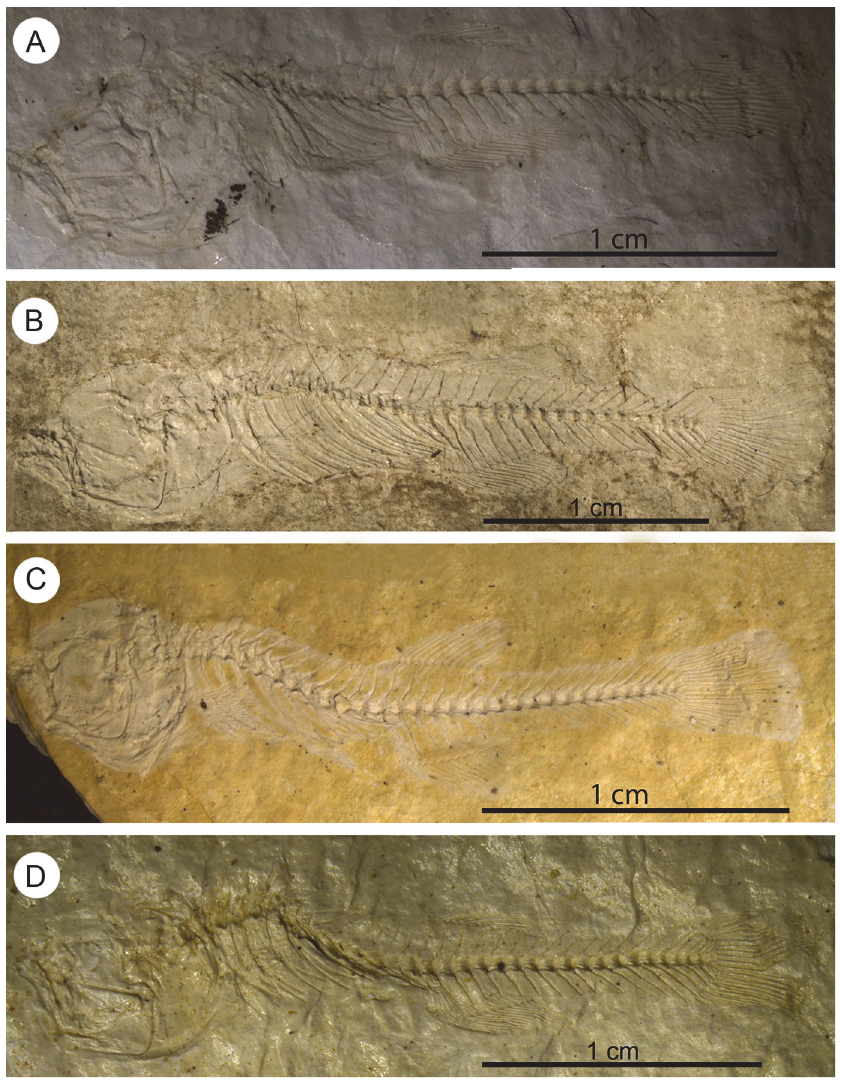
Fig 5. General view of four specimens of † K . kipkechi sp. nov. showing the varying extent of curvature of the vertebral column. A , straight (paratype 1146´04, mirrored); B , almost straight (paratype 1228(1)´04, mirrored); C , strongly curved (paratype 1168´04); D , strongly curved (paratype